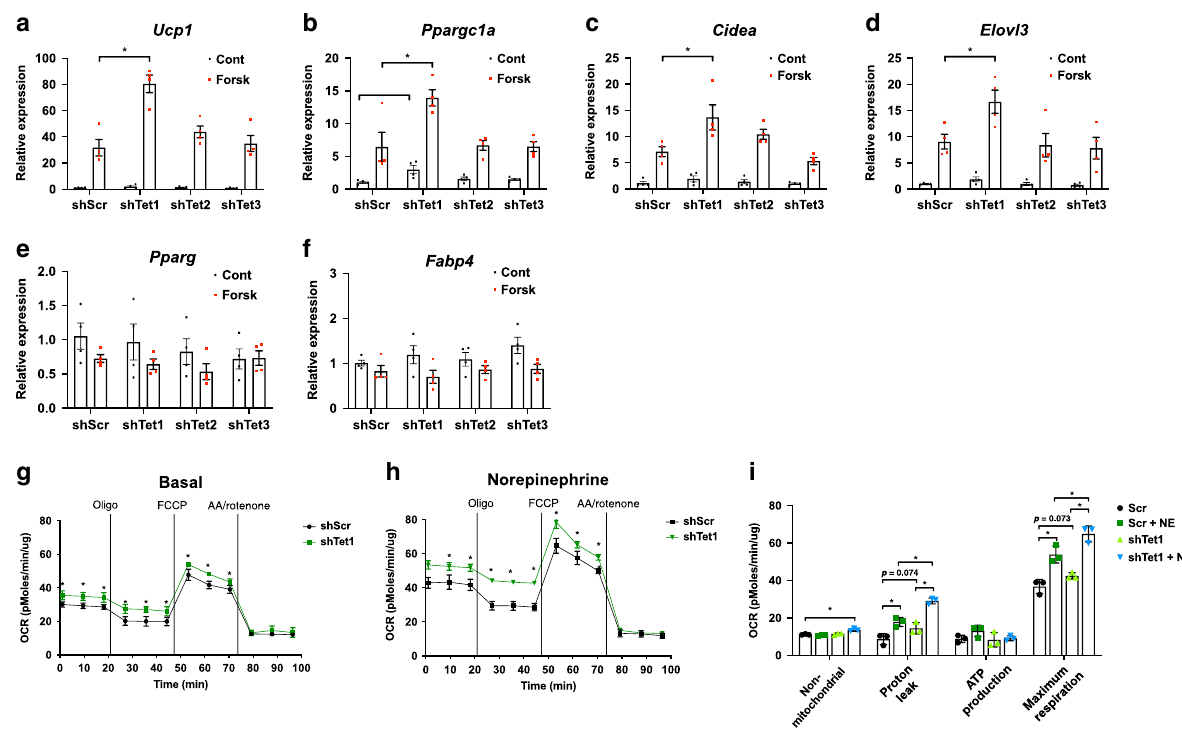
Fig. 2 Tet1 loss-of-function in vitro increases thermogenesis in beige adipocytes. a – f Differentiated beige adipocytes were transduced with hairpins against Tet1 , 2 , and 3 and scrambled control shRNA (shScr). The basal- and forskolin-stimulated levels of key adipocyte thermogenic gene transcripts were measured by qPCR ( n = 4 per group. Data are expressed as means ± SEM. *denotes p < 0.05, determined by two-tailed Student ’ s t test and two-way ANOVA followed by Bonferroni post-hoc testing). g – i Basal and norepinephrine (NE)-stimulated mitochondrial respiration under various drug treatments was measured in Tet1 knockdown and scramble beige adipocytes ( n = 3 per group. Data are expressed as means ± SEM. *denotes p < 0.05, determined by two-tailed Student ’ s t test and one-way ANOVA). (Oligo; Oligomycin, AA; antimycin A). i Shown are the various components of oxygen consumption rates with and without NE stimulation from ( g , h ). ( n = 3 per group. Data are expressed as means ± SEM. *denotes p < 0.05, determined by two-tailed Student ’ s t test and two-way ANOVA followed by Bonferroni post-hoc testing). Source data are provided as a source data fi